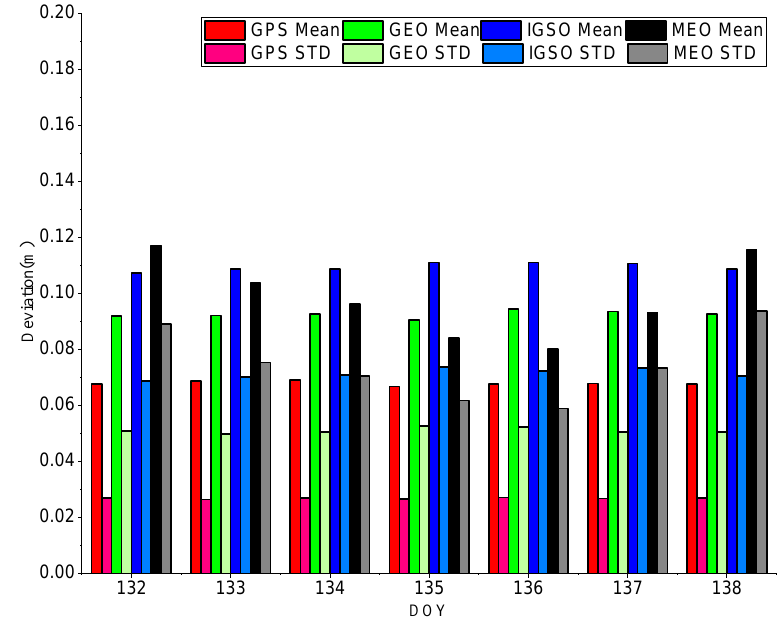
Figure 2. ComNav statistical results of the C/A and B1 code precision of different types of observations. GPS = global positioning system; GEO = geostationary orbit; IGSO = inclined geosynchronous orbit; MEO = medium-altitude Earth orbit; STD = standard deviation; DOY = day of the